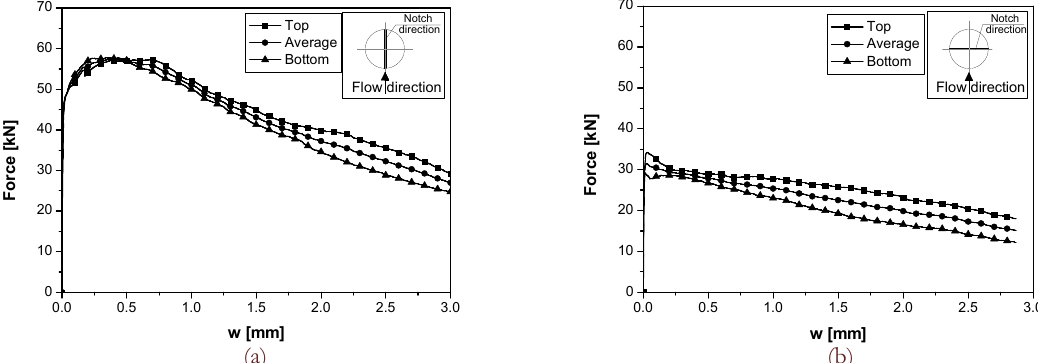
Figure 5: Nominal tensile stress – crack opening width relationship, σ – w, obtained from splitting tensile test for the two sides (top and bottom) of the specimens: (a) θ = 0 ° and (b) θ = 90 °